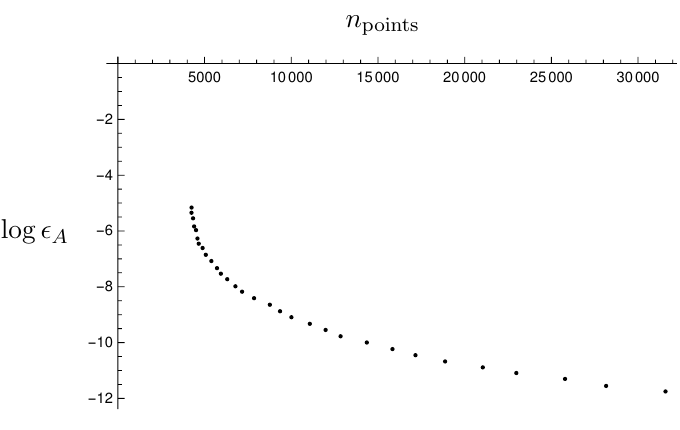
Figure 25 . Estimation of (cid:15) A as a function of number of lattice points n points